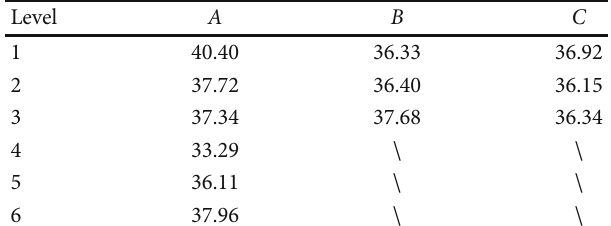
Table 6: The average value of THD.